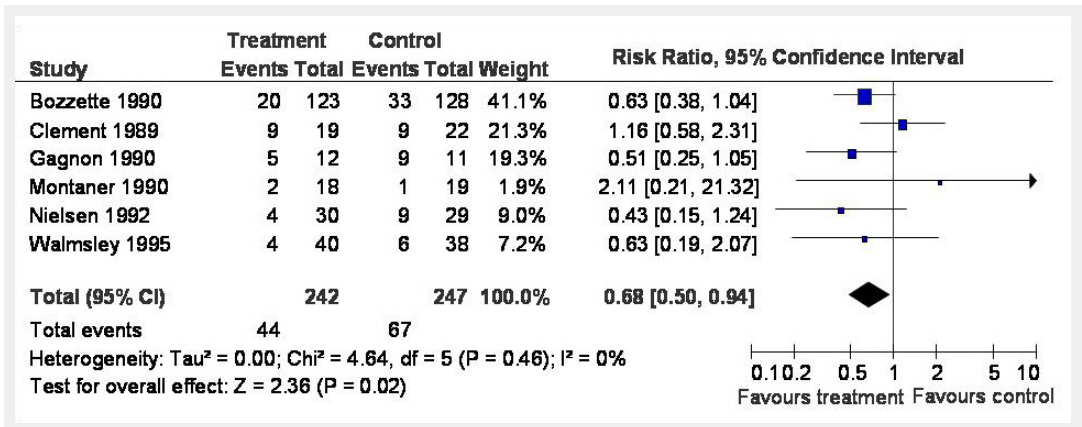
Figure 2 Forest plot of randomised controlled trials comparing the effect of steroids to placebo/usual care for pneumocystis jirovecii pneumonia on mortality. The centre of the squares and the horizontal lines correspond to the relative risk or risk ratio (RR) and 95% confidence intervals (CIs). The area of the squares is proportional to the weight each trial contributes to the meta-analysis. The diamond at the bottom of the graph represents the summary RR and its 95% CI indicating a reduction of 32% (95% CI 6 to 50%) in the risk of death when adjunctive corticosteroids are used in pneumocystistis jiroveci pneumonia. The solid vertical line corresponds to no effect of treatment (RR 1.0). The RR, 95% CI and weights are also given in tabular form (adapted from [48] Briel M, Bucher HC, Boscacci R, Furrer H: Adjunctive corticosteroids for Pneumocystis jiroveci pneumonia in patients with HIV-infection. Cochrane Database Syst Rev. 2006 Jul 19;3:CD006150. Reprinted with the permission from John Wiley and Sons).